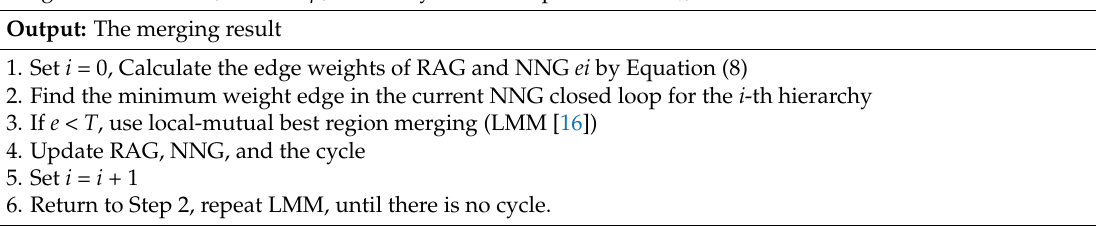
Table 1. Multiscale hierarchical grouping.